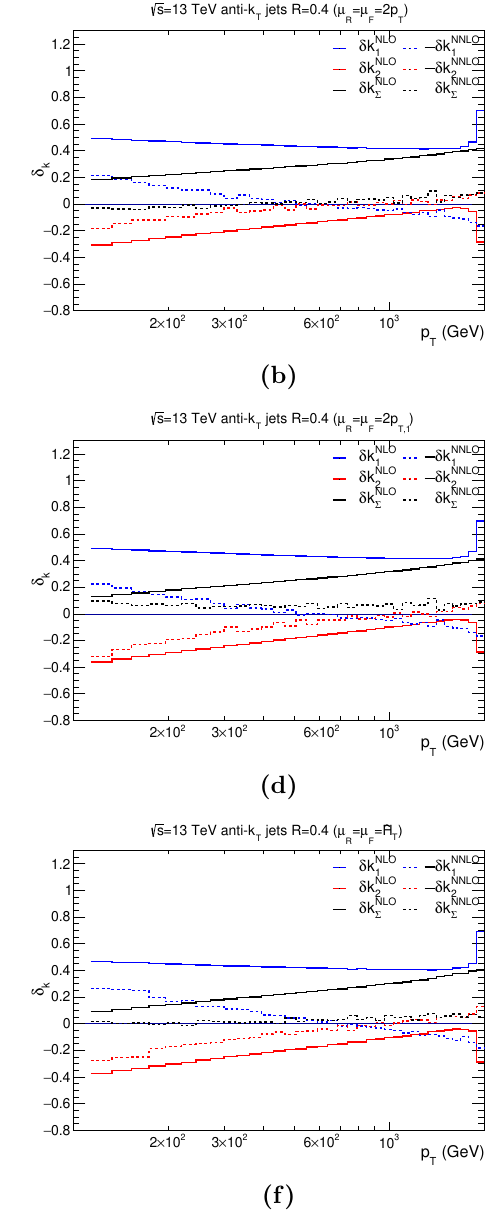
p Figure 13 . Di(cid:11)erential correction factors at s = 13 TeV for the leading jet ( (cid:14)k N k LO , blue), 1 subleading jet ( (cid:14)k N k LO , red) and the inclusive jet distribution ( (cid:14)k N k LO , black) with R = 0 : 4 and 2 (cid:6) integrated over rapidity for the scale choices (a) (cid:22) = p T , (b) (cid:22) = 2 p T , (c) (cid:22) = p T ; 1 , (d) (cid:22) = 2 p T ; 1 , (e) (cid:22) = ^ H T = 2, (f) (cid:22) = ^ H T